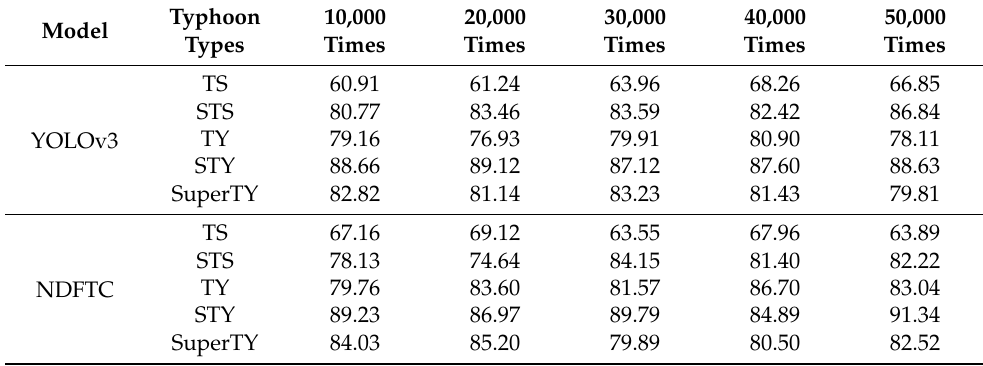
Table 2. AP performance of the NDFTC and other models on the test set for five kinds of TCs. Model